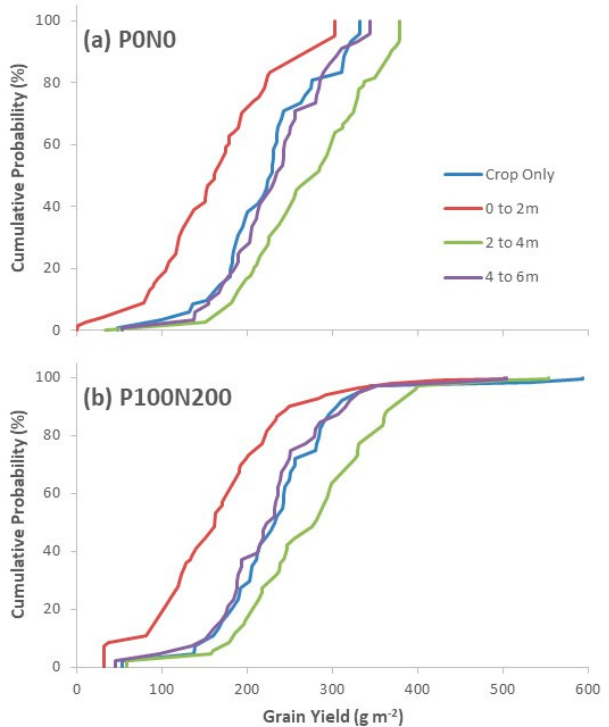
Figure 4. Cumulative probability of maize yield (1977–2016) by zone under two contrasting growth conditions (i.e., without pruning or fertilizer (P0N0)) ( a ), and with 100% pruning and high N fertilizer (P100N200) ( b ).